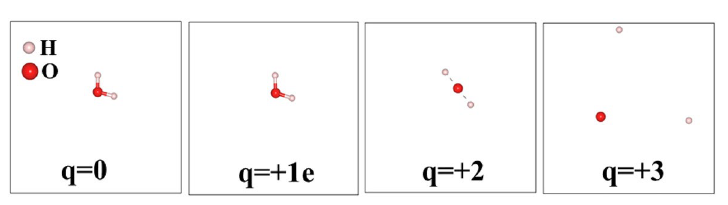
Figure 4. The effect of electron removal in water molecule.